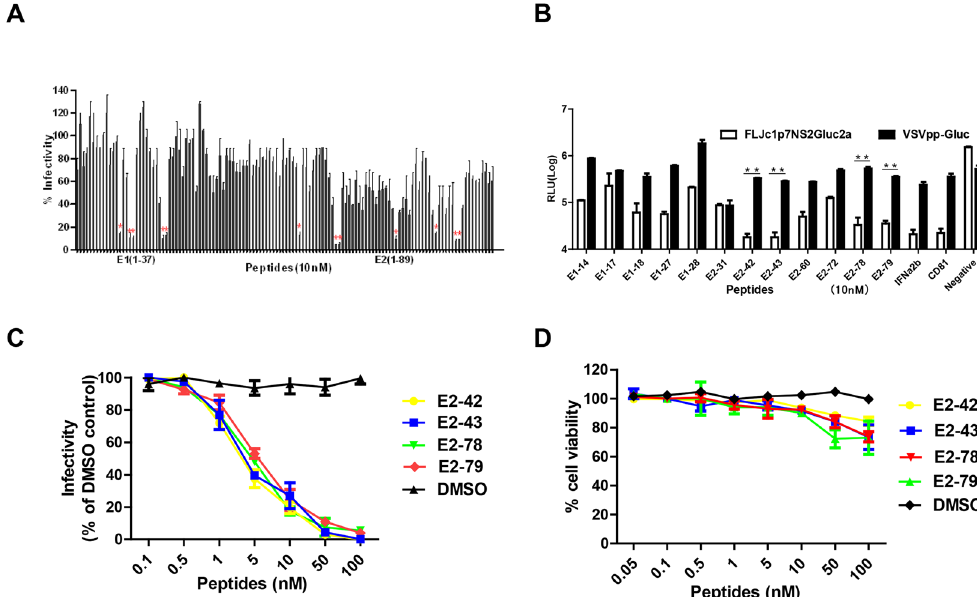
Figure 1. Identification of HCV E1E2-derived peptides with antiviral activity against HCVcc infection. ( A ) Effects of E1E2-derived peptides on HCV E1E2-mediated infection. HCVcc Jc1P7NS2Gluc2a was used to screen for antiviral activity. HCVcc was incubated with 10 nM peptides for 1 h prior to addition to Huh7.5/ CD81 cells, and Gaussia luciferase activity was assayed 72 h later. The results were normalized to DMSO-treated cells. ( B ) Characterization of the specificity of inhibitory peptides against HCVcc infection. HCVcc and VSV- Gpp (VSV-G-pseudotyped lentivirus) were incubated with 10 nM peptides for 1 h. Then, Huh7.5/CD81 cells were inoculated for 4 h with virus/peptide mixtures, and Gaussia luciferase activity was assayed 72 h later. IFN- α and anti-CD81 antibodies were used as positive controls, and DMSO was used as a negative control. ( C ) The ED50 values of peptides were calculated based on their inhibition of HCVcc activity at different peptide concentrations. ( D ) Cytotoxicity of peptides against Huh7.5/CD81 cells by MTT assay. Each bar represents the average of triplicate data points, with the standard deviation indicated by the error